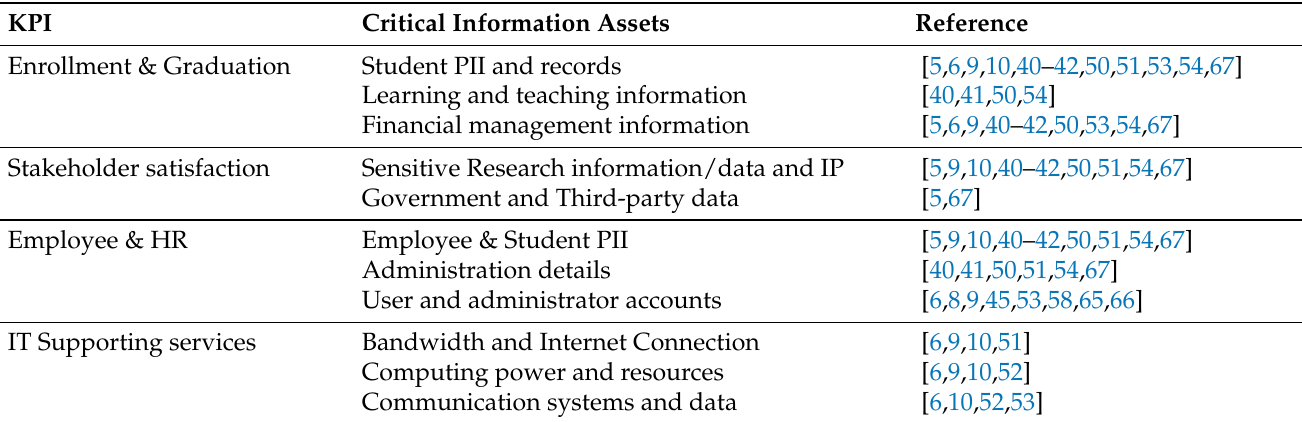
Table 4. Proposition of the most valuable information assets based on KPI. References for each asset is listed in the right column.